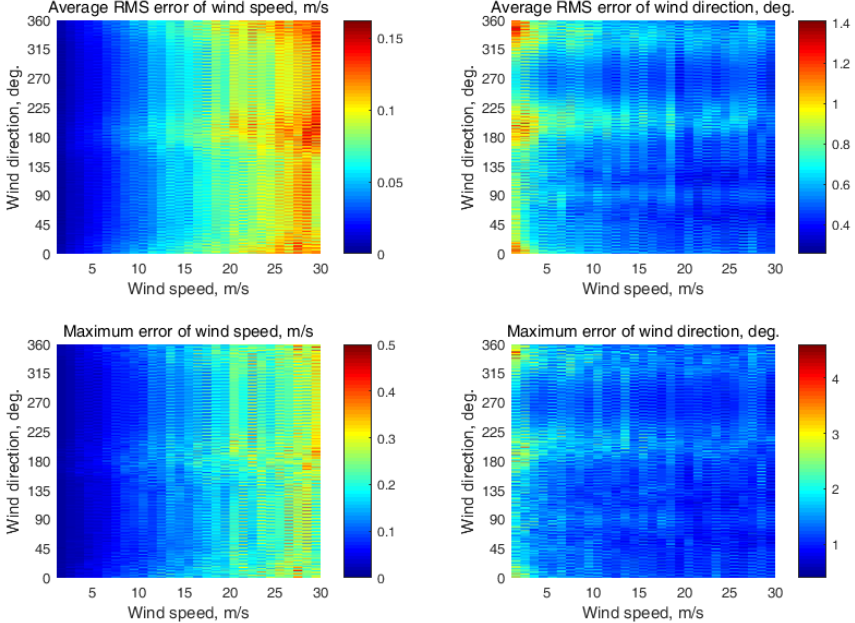
Figure A13. Semicircular wind retrieval results at the (50°, 55°) incidence angle combination.